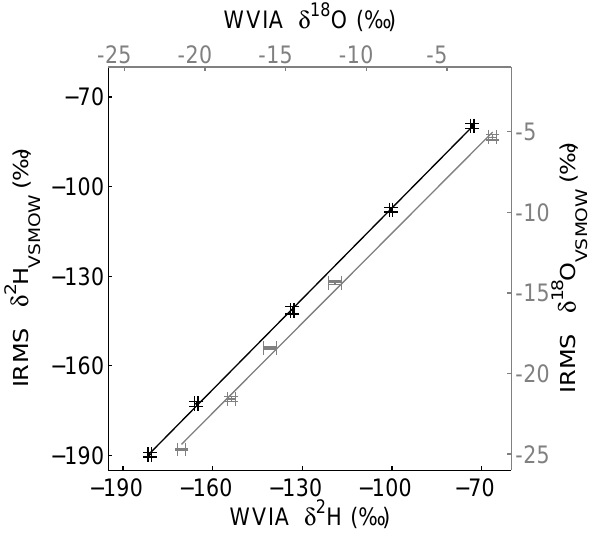
Fig. 9. Calibration of δ 2 H (black) and δ 18 O (grey) with dif- ferent water standards. Weighted least squares fit through the data results in δ 2 H IRMS = ( 1 . 013 ± 0 . 011 )δ 2 H WVIA − ( 5 . 82 ± 1 . 53 ) and δ 18 O IRMS = ( 1 . 007 ± 0 . 019 )δ 18 O WVIA − ( 2 . 92 ± 0 . 32 ) (solid lines), R 2 > 0 . 99.